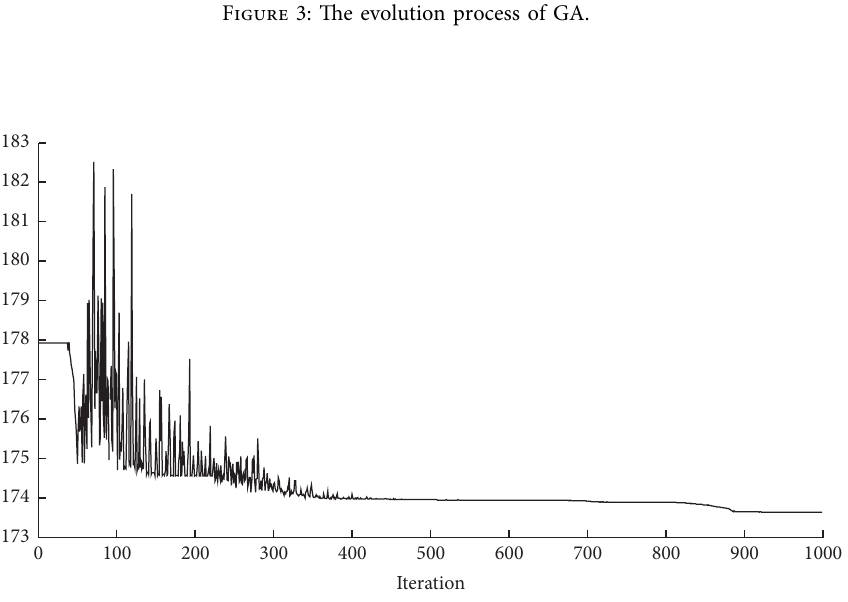
Figure 4: The evolution process of